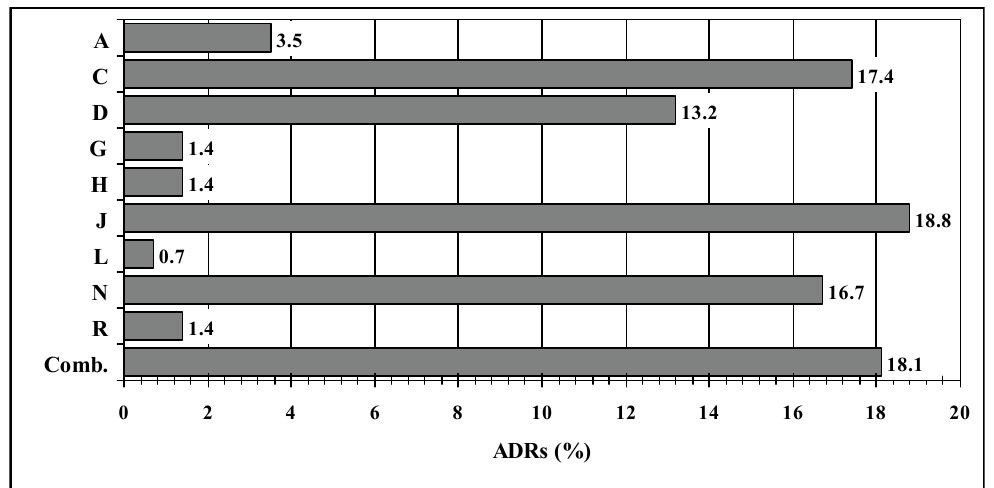
Figure 1. Distribution of ADRs according to the eliciting drug groups (ATC